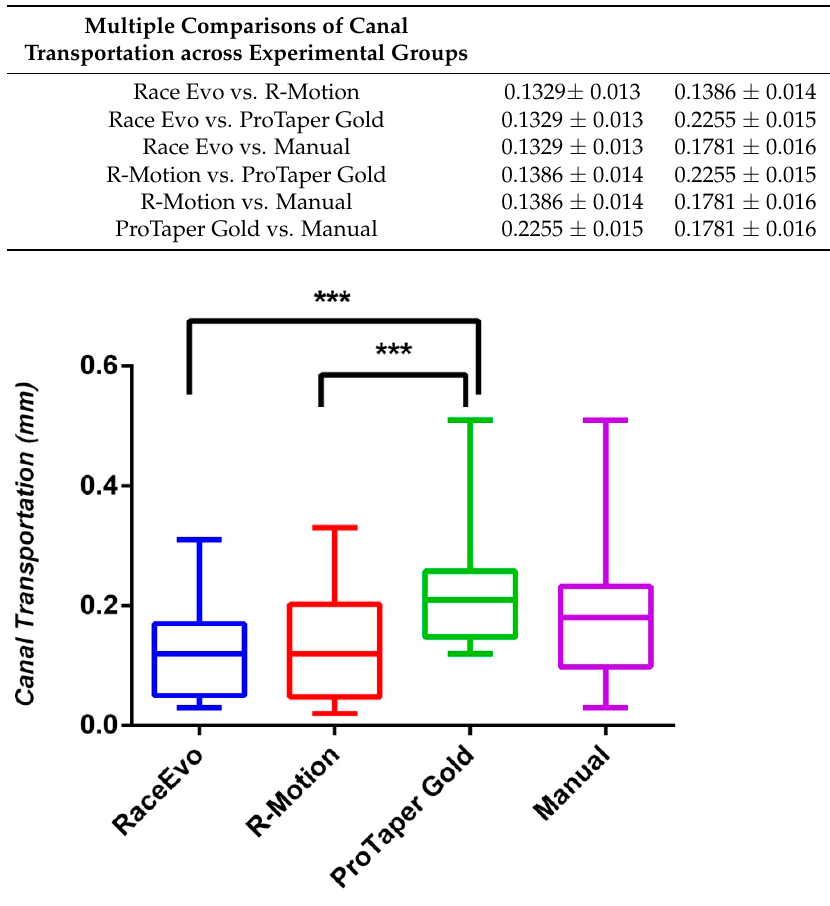
Figure 4. Canal transportation across experimental groups. Results are expressed as mean values ± SEM. (*** p < 0.001).